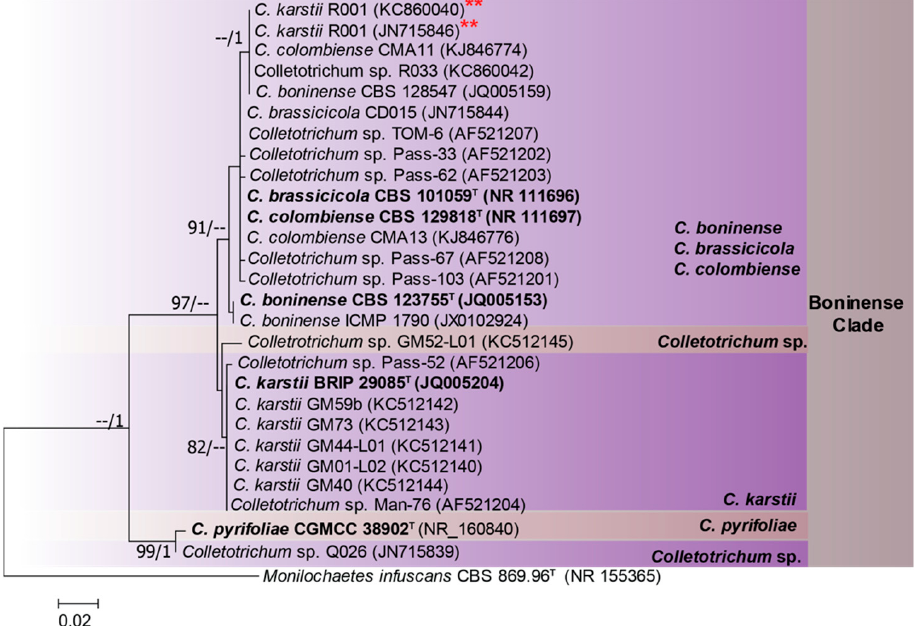
Figure 3. An ML tree of the boninense clade that includes species reported in northern South America (Colombia, Ecuador, Peru, and Venezuela). The tree was created based on the alignment of ITS (449 bp). The GenBank accession numbers of sequences retrieved from the database are given in parentheses. Reference strains are shown in bold. Branch lengths are proportional to phylogenetic distance. The best substitution model for ML was determined to be T92+G. Bootstrap support values/Bayesian posterior probability scores above 70%/0.95 are indicated on the nodes. The tree was rooted to Monilochaetes infuscans CBS 869.96. T = Ex-type strain. ** Isolates are probably mislabeled in